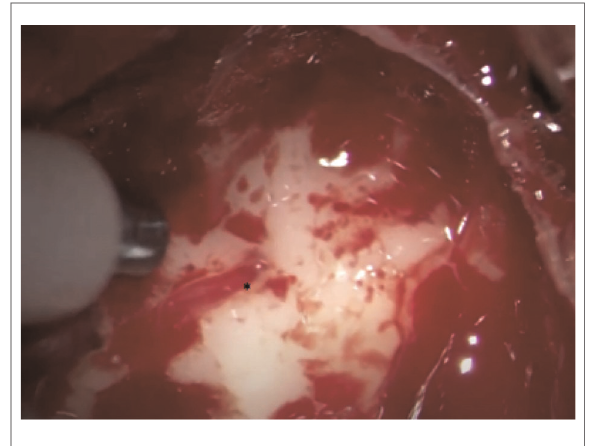
FIGURE 16 Intraoperative image showing LSTa surrounding by the tumor. The lenticulostriate artery (*) is the tumor medial resection